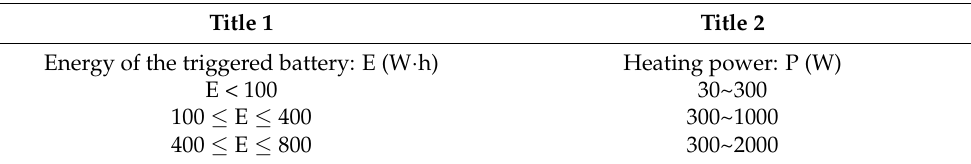
Table 2. The heating power selection for the heater in GB 38031.